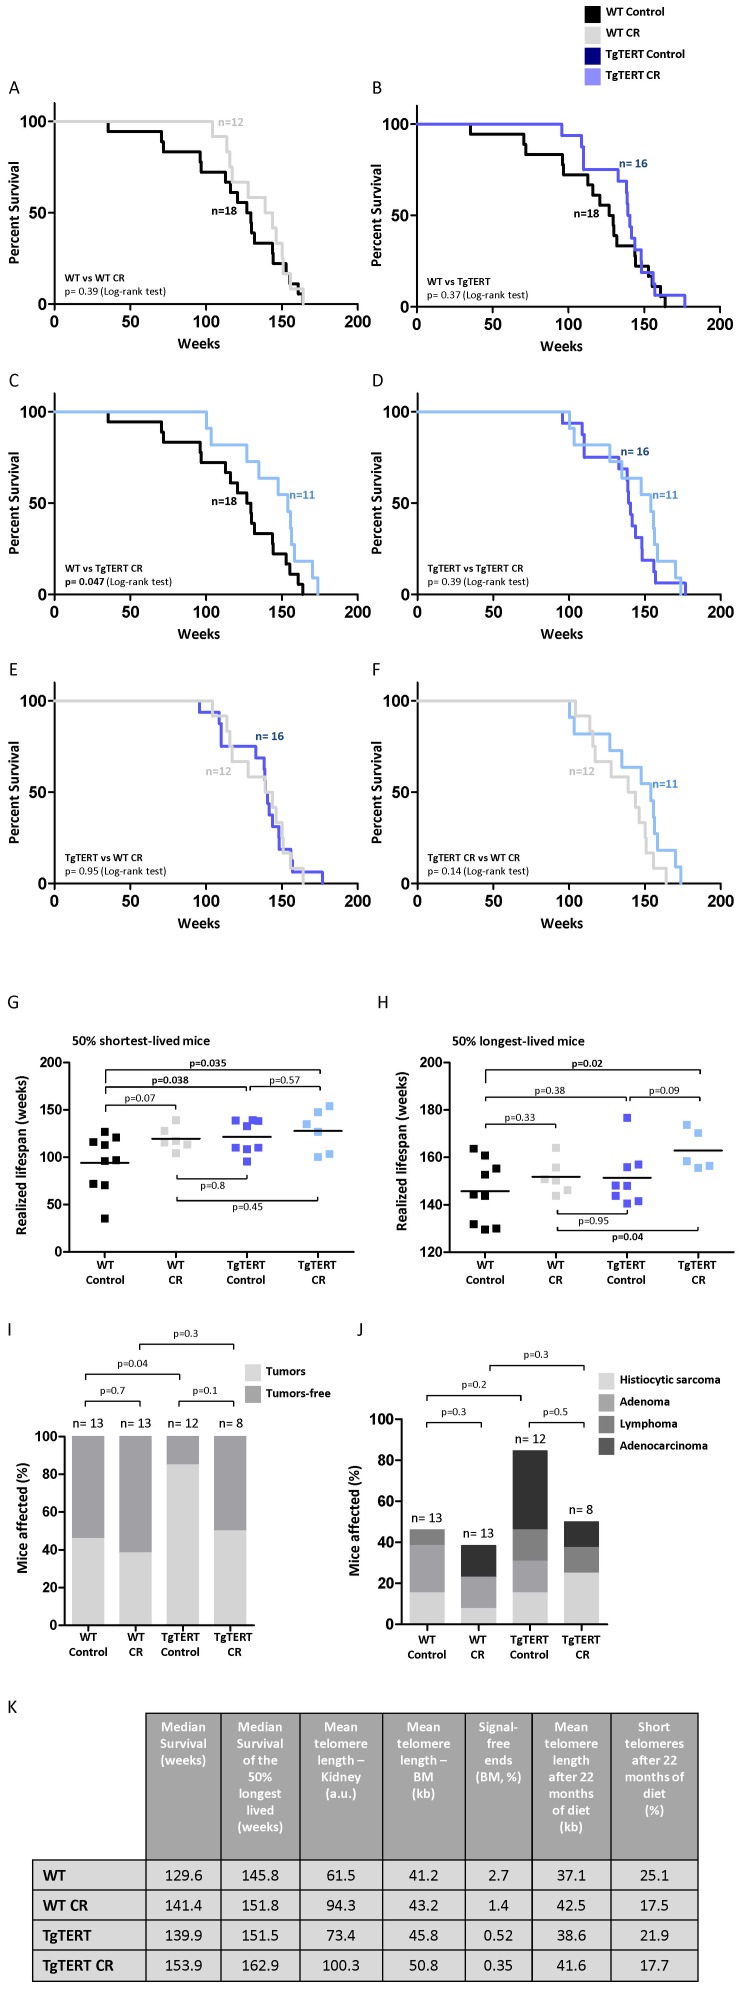
Caloric restriction increases median and maximum longevity and protects from cancer.(A–F) Kaplan-Meyer survival curves of the indicated mouse cohorts. The Log rank test was used for statistical analysis. Mice under CR were more susceptible to unexpected stresses such as the blood extraction procedure carried. 5 mice of the WT CR cohort and 6 mice of the TgTERT cohort died during the blood extraction and were excluded from the survival curves (of note, none of the WT or TgTERT mice show sensibility to the blood extraction procedure). (G–H) Realized lifespan of the 50% shortest (G) and longest (H) lived mice of each cohort. Student´s t-test was used for statistical analysis. (I) Percentage of mice with cancer and cancer-free mice in the different cohorts. All death mice were subjected to full histopathological analysis. (J) Percentage of mice in the different cohorts with the indicated tumours at their time of death. (K) Summary table with the findings regarding telomere length and survival of the different cohorts.